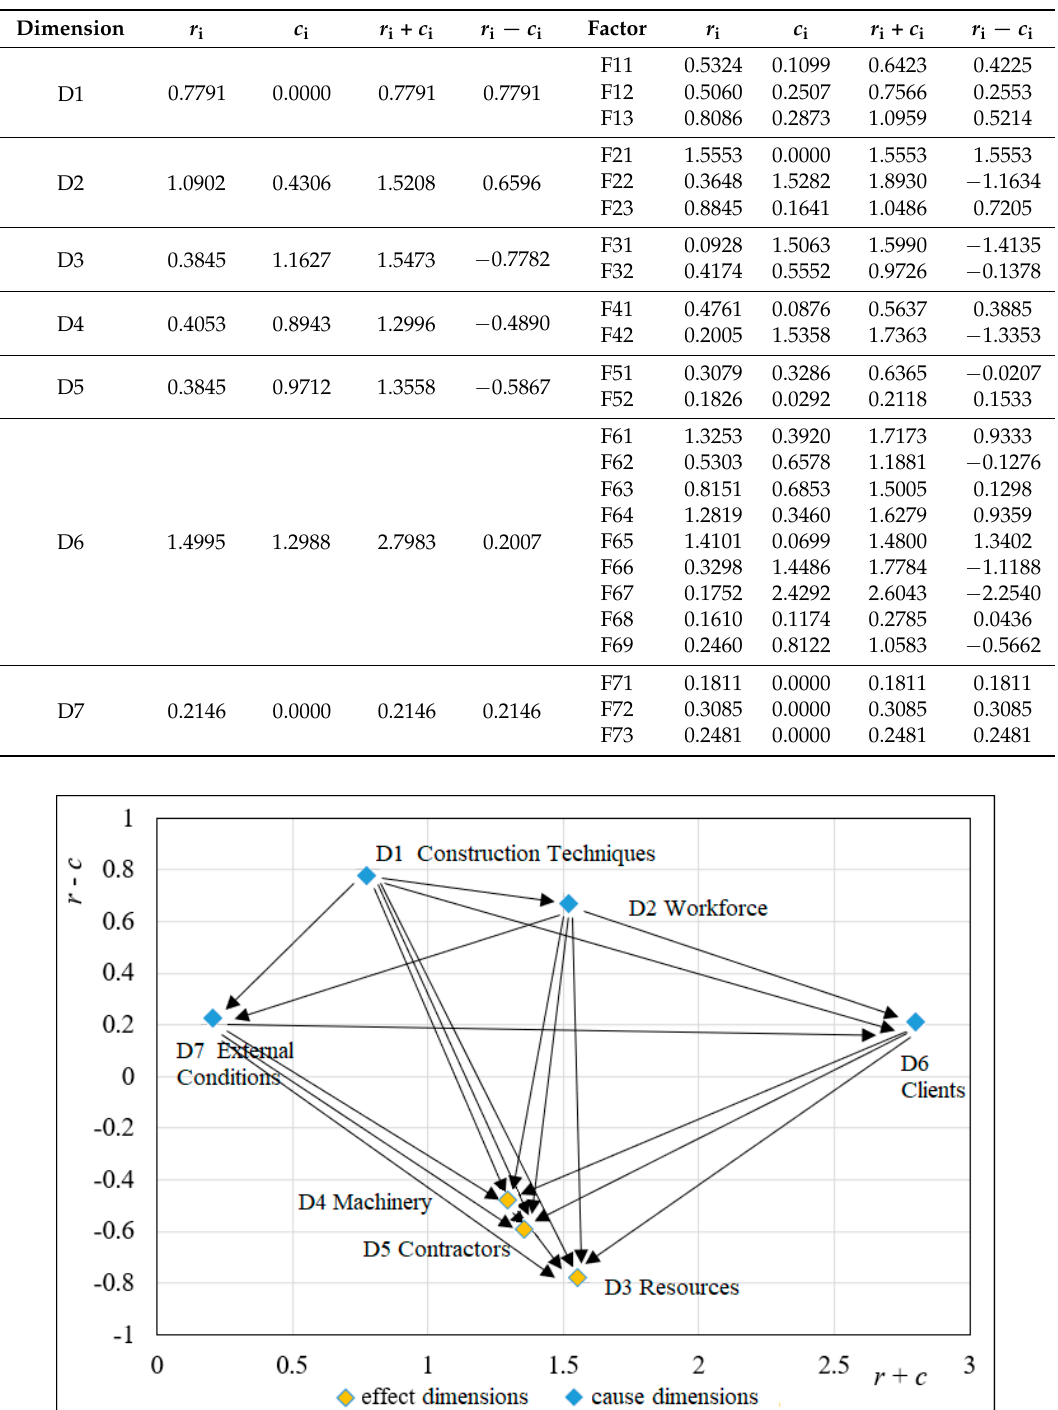
Table 5. Sum of influences given to and received from other factors.